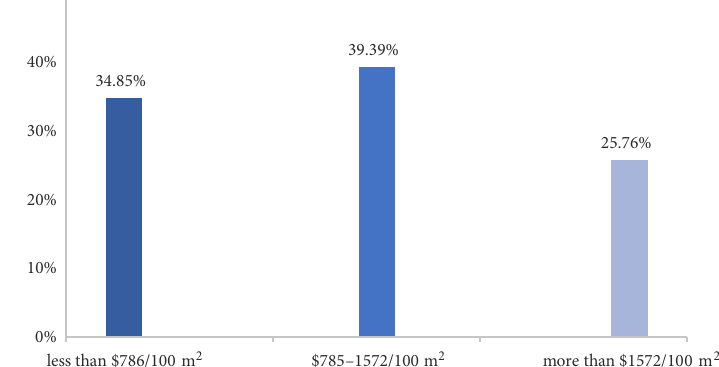
Figure 5. Distribution of positive WTP